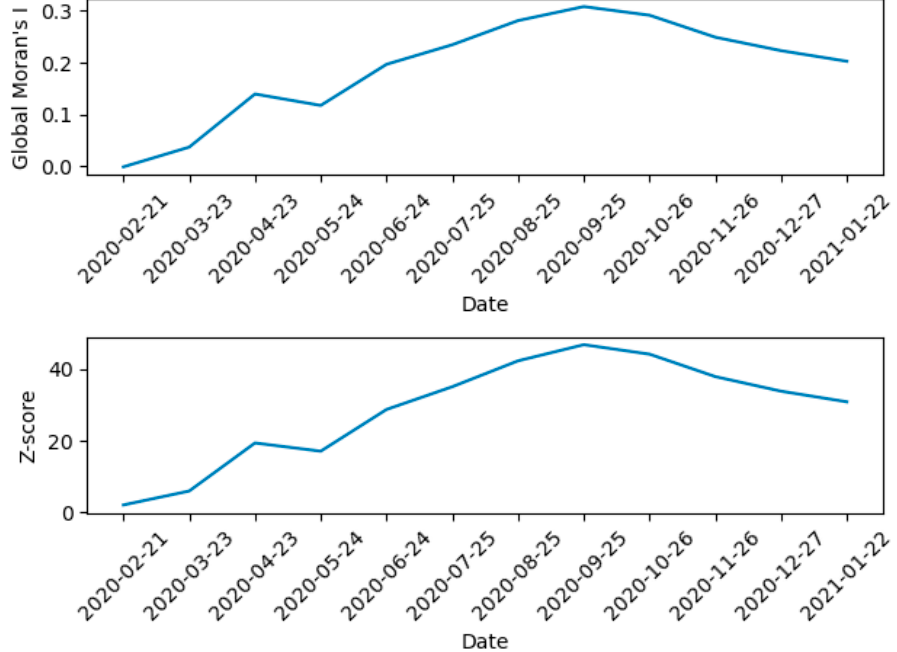
Figure 2. Global spatial autocorrelation of the global COVID-19 pandemic over time.